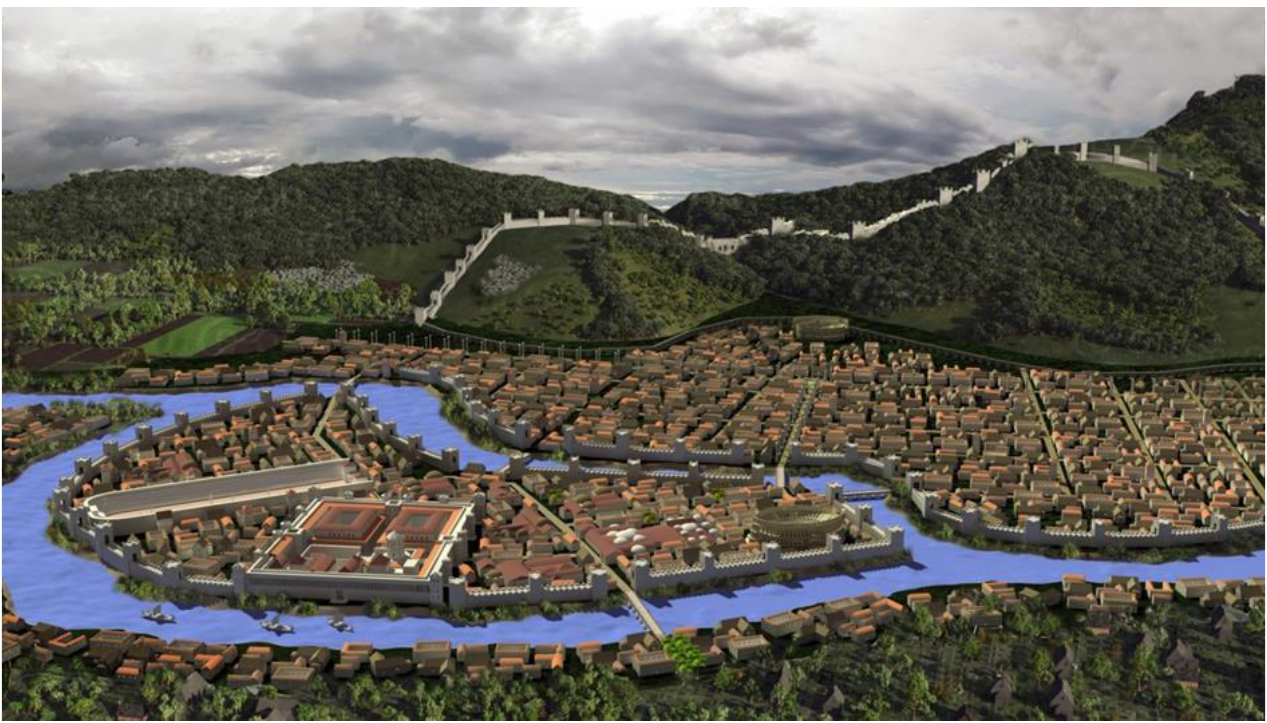
Figure 5. Model of Ancient Antioch as situated along the Orontes River.